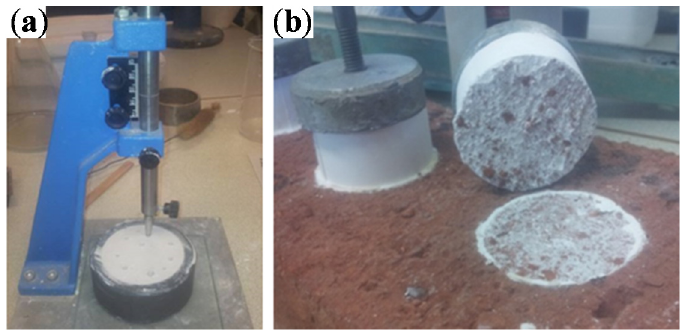
Figure 2. ( a ) Vicat needle; ( b ) Adherence test.